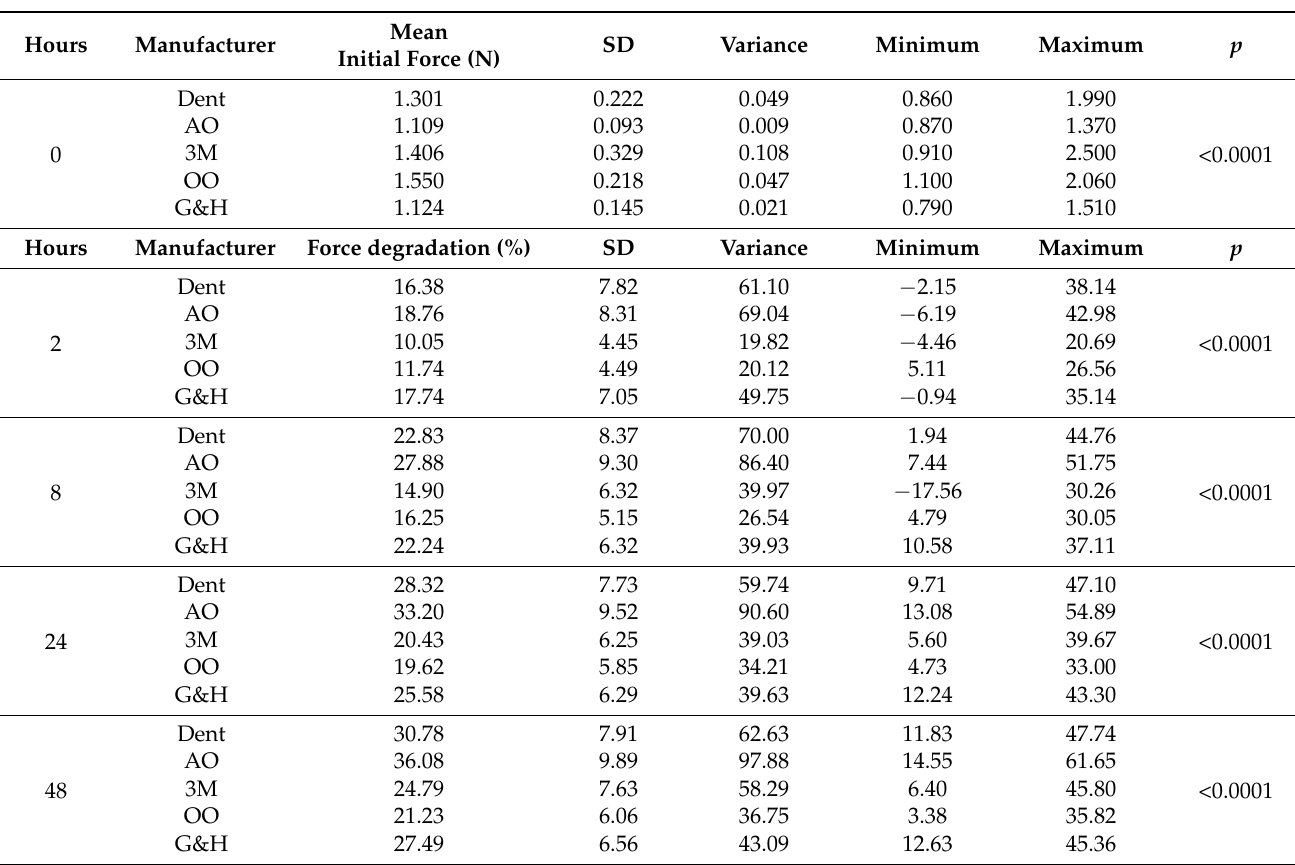
Table 2. Mean initial forces in newtons and force degradation in percent at 2, 8, 24, and 48